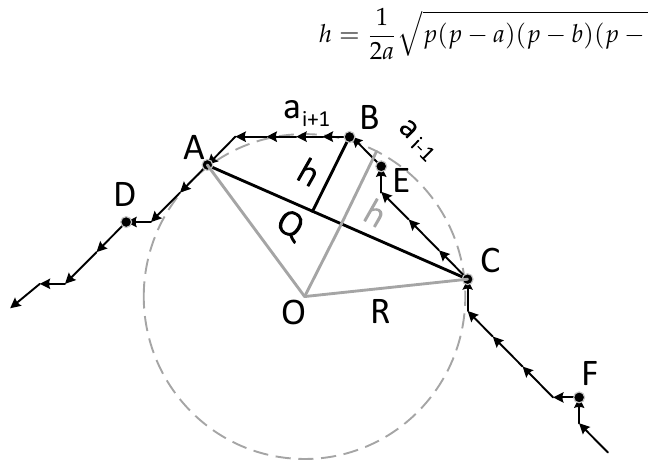
Figure 9. Schematic diagram of the geometric feature extraction method.